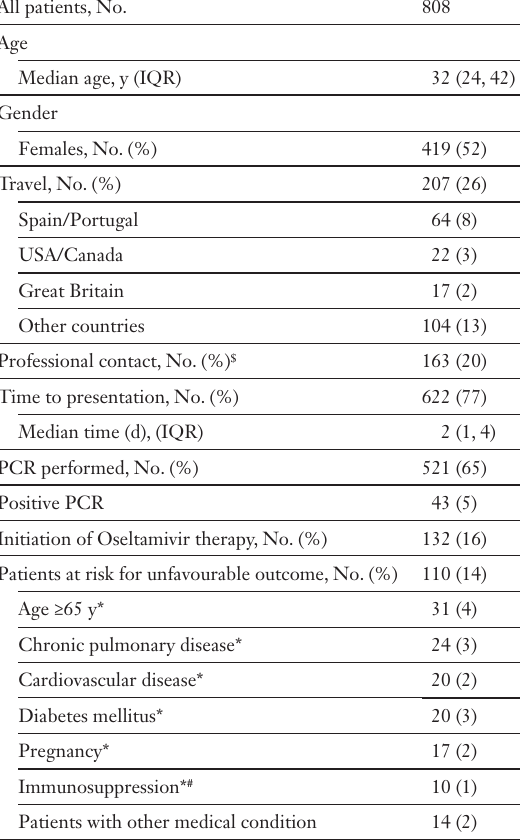
Demographics of ED patients with flu-like symptoms.